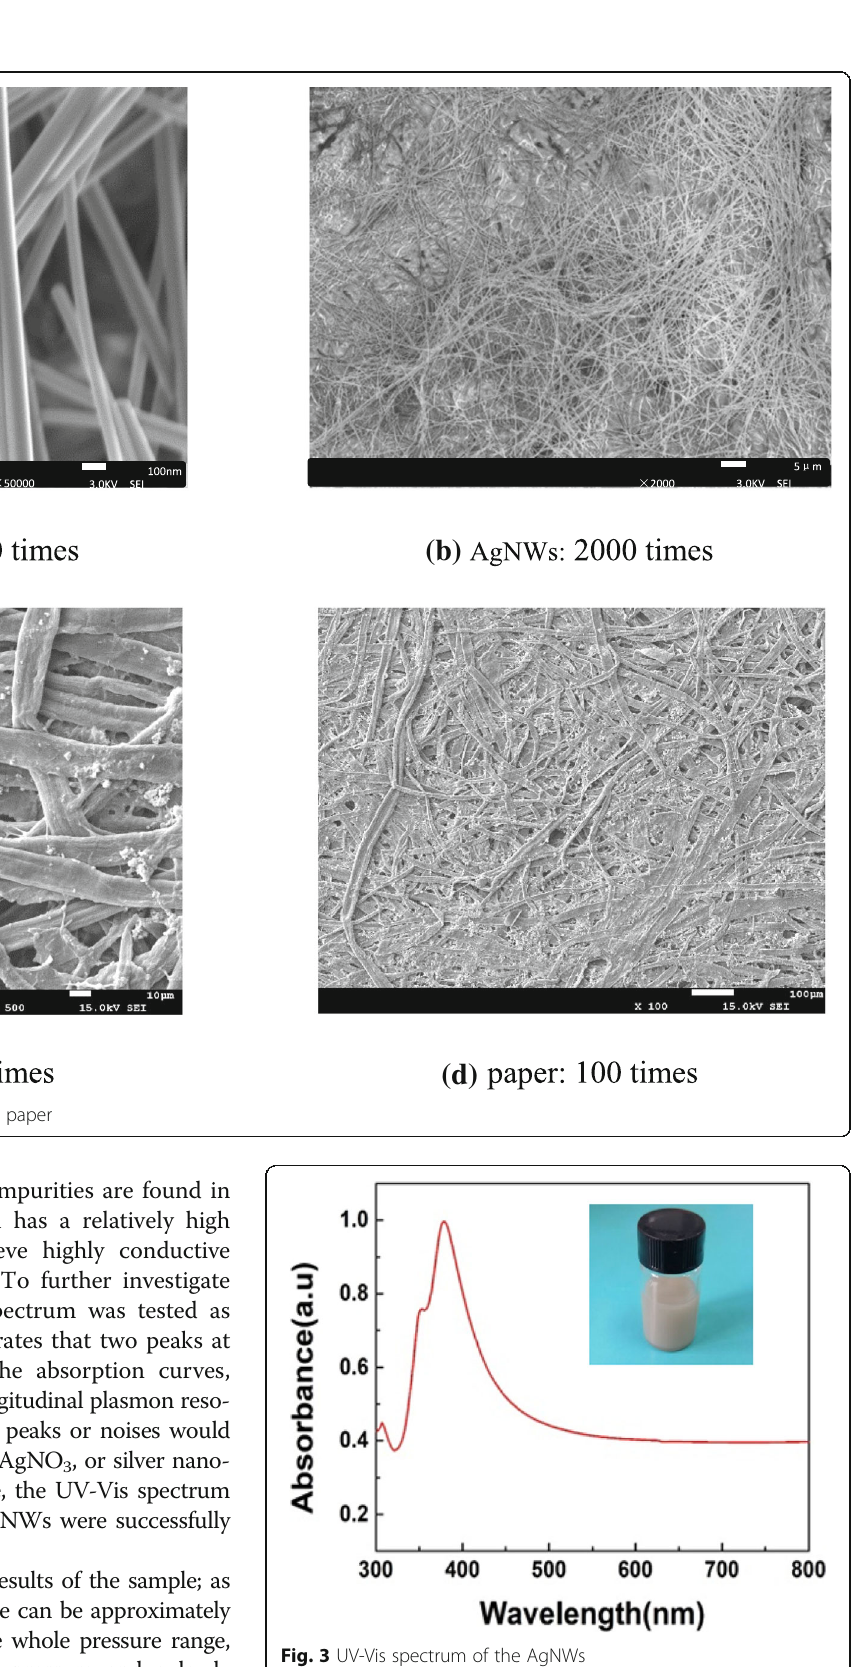
Fig. 3 UV-Vis spectrum of the